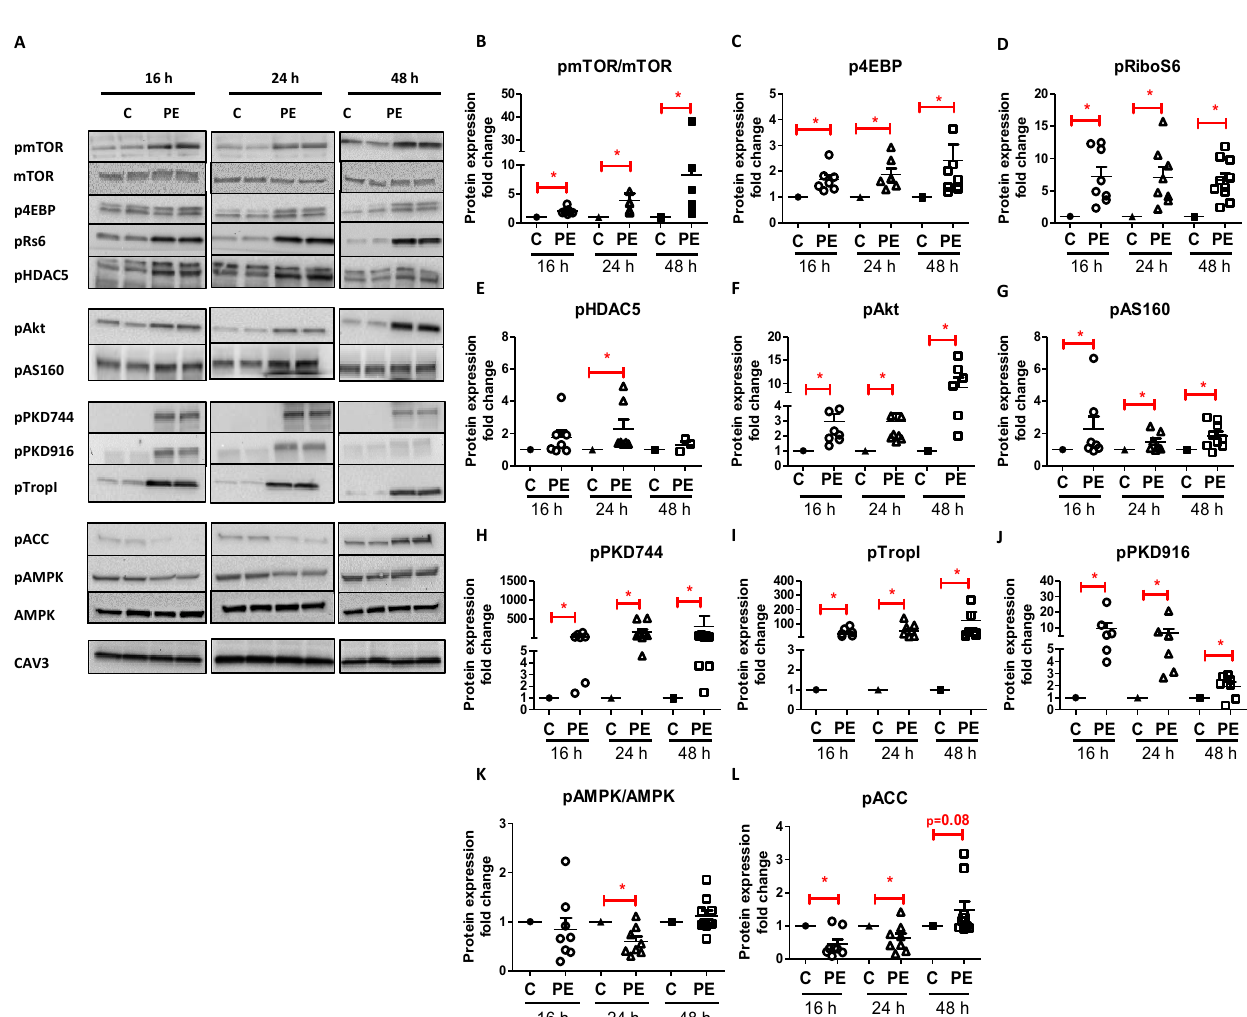
Figure 2. Time-dependent effect of phenylephrine on cellular signaling. ( A ) Representative Western blots showing phosphorylation levels of proteins involved in either protein synthesis (p-mTOR(ser2448), total mTOR, p-4EBP(Thr37/46), p-rS6(Ser235/236), and p-HDAC5(Ser498)) or the regulation of cellular glucose uptake (p-Akt(Ser473), p-AS160(Thr642), p-PKD1(Ser744), p-PKD1(Ser916), p-TropI(Ser23/24), p-AMPK(Thr172), total AMPK, and p-ACC(Ser79)) after 16 h, 24 h, and 48 h phenylephrine (50 µ M) stimulation. ( B – L ) Quantification of these protein levels normalized to Caveolin 3 (CAV3). Values are expressed as fold increase ± STDEV relative to their control at the same incubation time ( n = 7/ n = 9). * p < 0.05 was considered significantly different compared to control at the same incubation time.